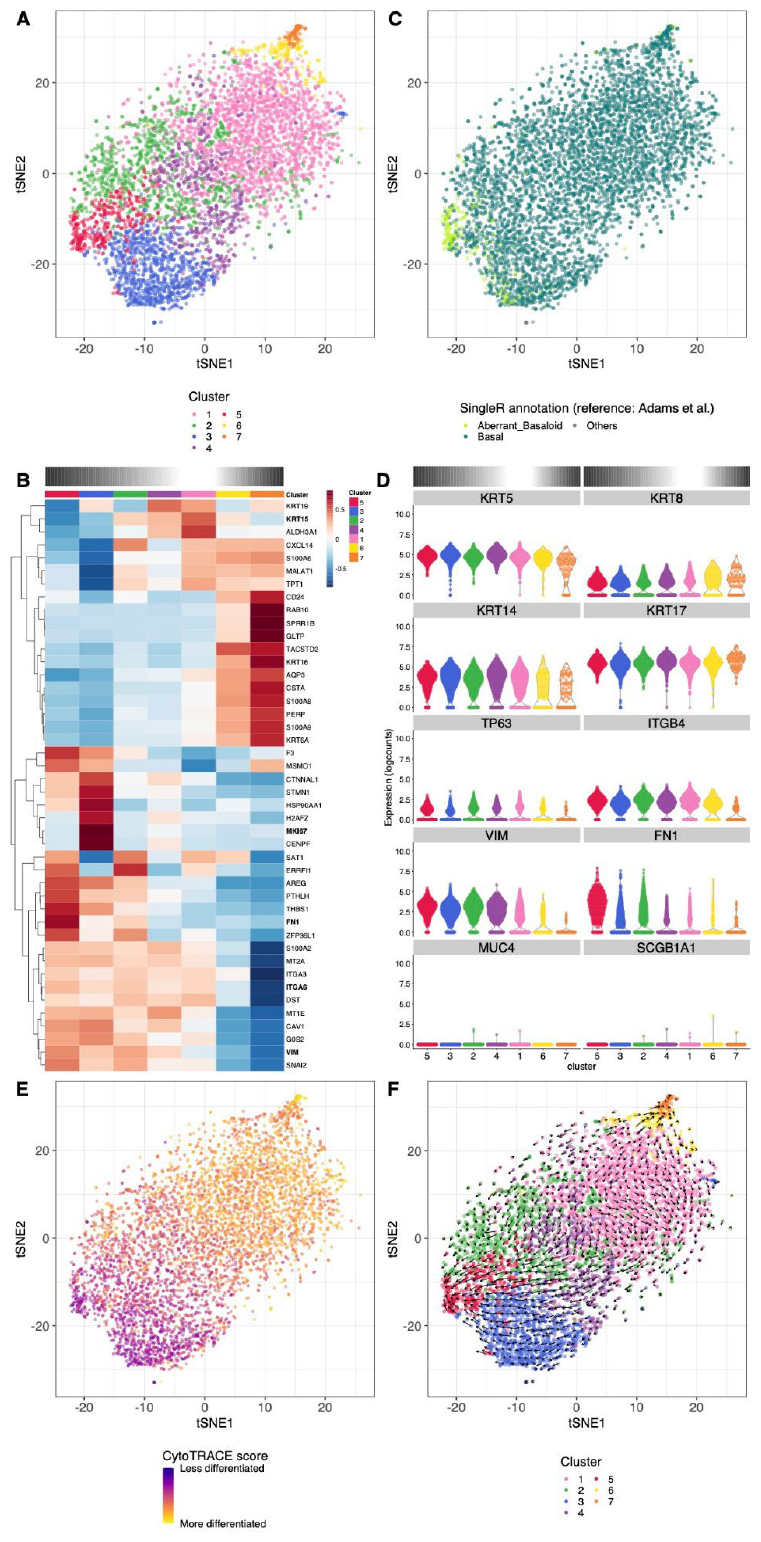
Figure 5. Clustering and cell type annotation of alveolar basal cells cultured in Cnt-PR-A. ( A ) tSNE showing the separation of the cells into seven clusters. ( B ) t-SNE showing the best matching cell